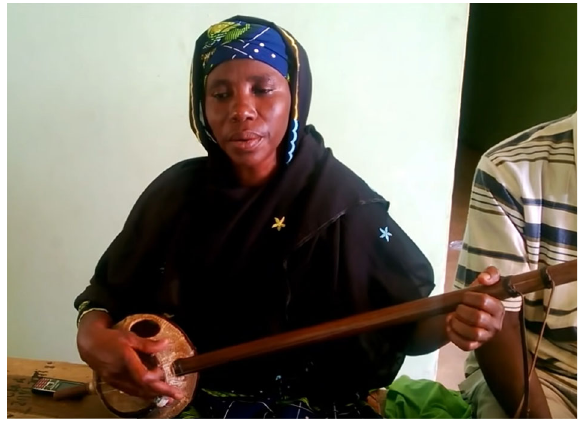
Fig. 3 Hausa gurmi played by Salamatu Mai Gurmi, collected by Abdalla Ubu Adamu (still from YouTube video [Adamu, 2013]). The gurmi is constructed by stretching a membrane across an open gourd resonator, which is closed by a vibrating skin membrane. The round neck fully penetrates the resonator, and the strings are attached to the neck with leather tuning knots. Note also the downstroking style of performance, also seen in early banjo